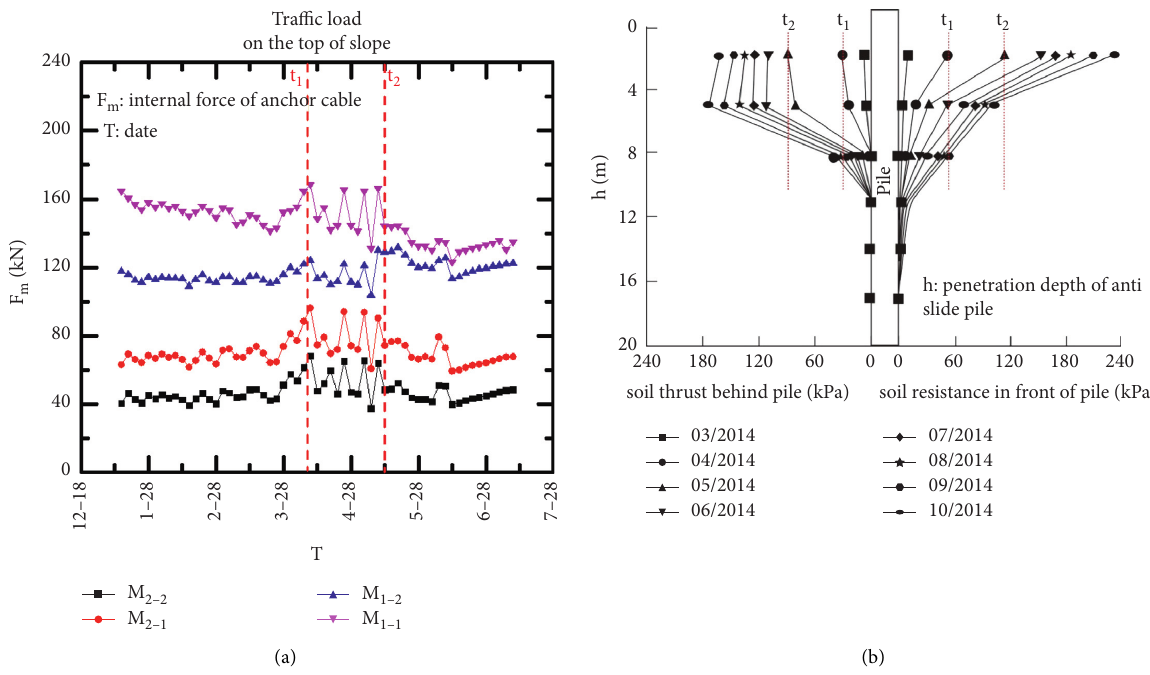
Figure 13: Internal force monitoring curve of anchor cable and anti slide pile. (a) Internal force monitoring curve of anchor cable. (b) Internal force monitoring curve of anti slide